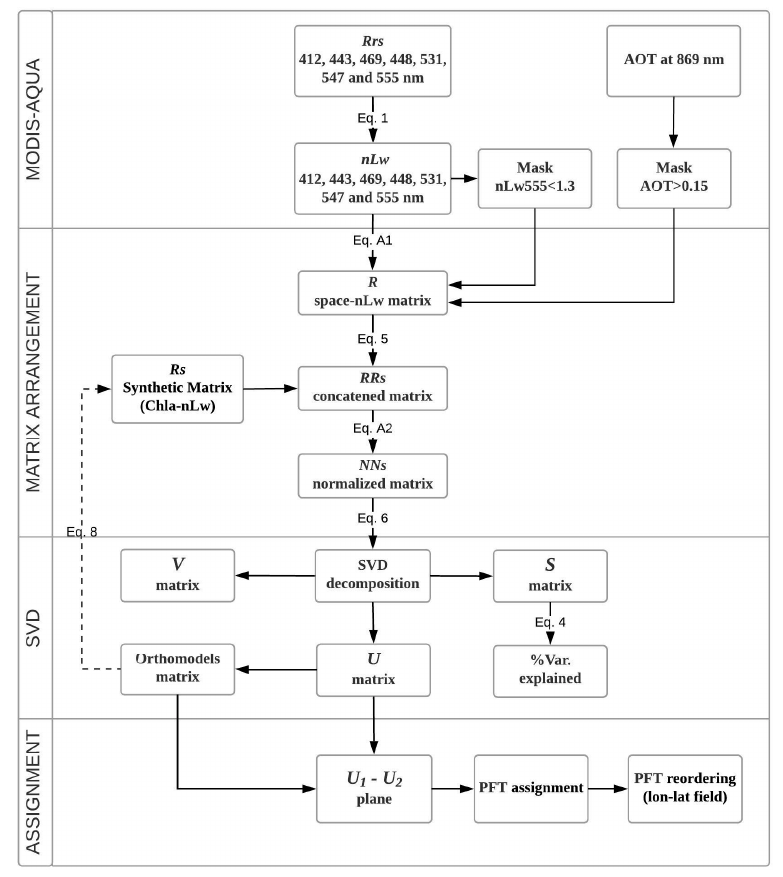
Figure 9. The schematic diagram summarizing the PHYSTWO method. The dashed arrow represents the process of orthomodels adjustment and their incorporation into the synthetic matrix.